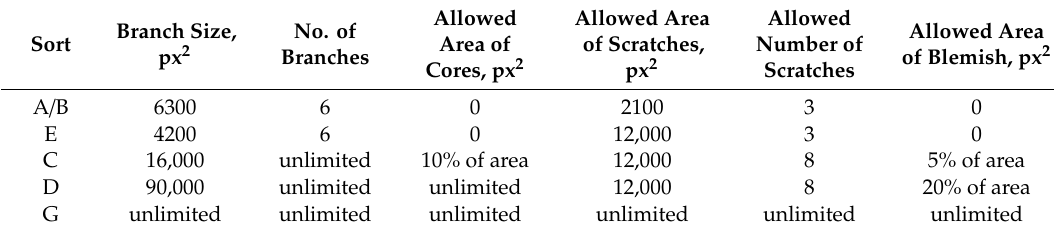
Table 1. Explanation of defect types.